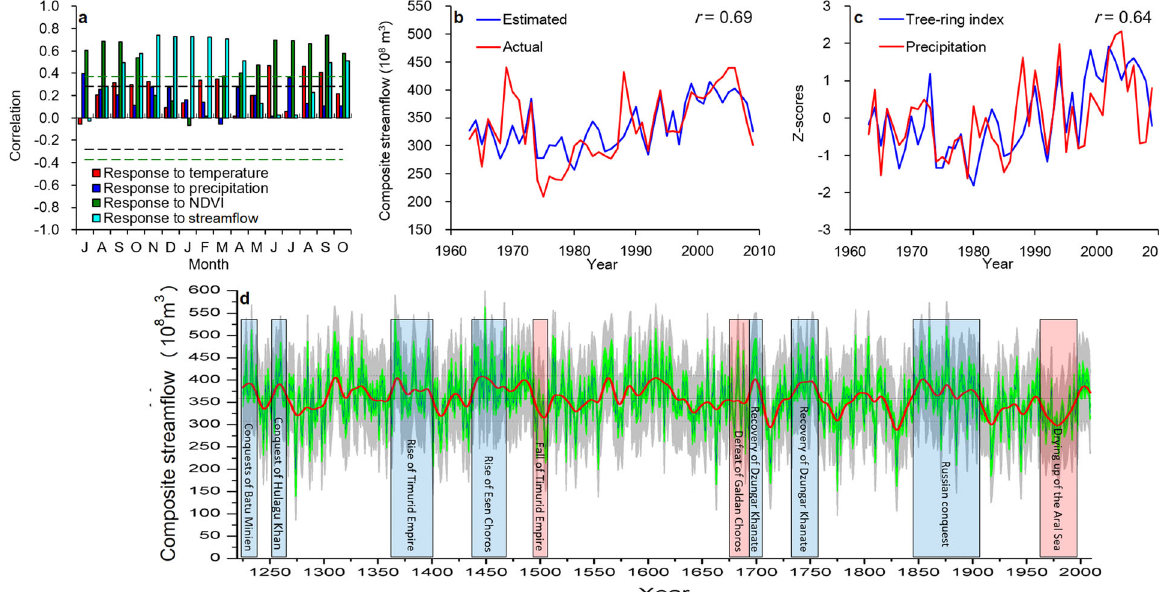
Fig. 2 Response of tree-ring width to to climate, NDVI and stream fl ow and stream fl ow reconstruction. a Responses of the composite chronology to monthly mean temperatures, precipitation sum, composite stream fl ow, and NDVI. Correlations are computed from the previous year in July to the current year in September over the common period. The horizontal dashed lines indicate the 95% signi fi cance levels. b Actual and estimated total stream fl ow of the previous August to the current July for 1962 – 2009. c Comparison between tree-ring index and total July – April precipitation for 1962 – 2009. d Reconstructed August – July composite stream fl ow of the Syr Darya, Ili, Chu, and Jing rivers (blue curve) shown together with the two-tailed 95% bootstrap con fi dence limits (green) and ±1 root mean square error (RMSE) uncertainty estimates (gray) since 1225 CE. Red curve is a 21-year low pass fi lter. Reconstructed stream fl ow from 1225 to 1239, 1252 to 1260, 1361 to 1400, 1437 to 1467, 1494 to 1511, 1678 to 1692, 1693 to 1705/1731 to 1756, 1844 to 1905 and 1961 to 1996, corresponding to conquests of Batu Minien, Hulagu Khan ’ s conquests, rise of Timurid Empire, rise of Esen Choros, fall of Timurid Empire, defeat of Galdan Choros, recovery of Dzungar Khanate, Russian conquest and drying up of the Aral Sea, respectively. Blue and red boxes represent high and low stream fl ow conditions, respectively. Central horizontal line shows the average of stream fl ow estimates, and dotted lines indicate one standard